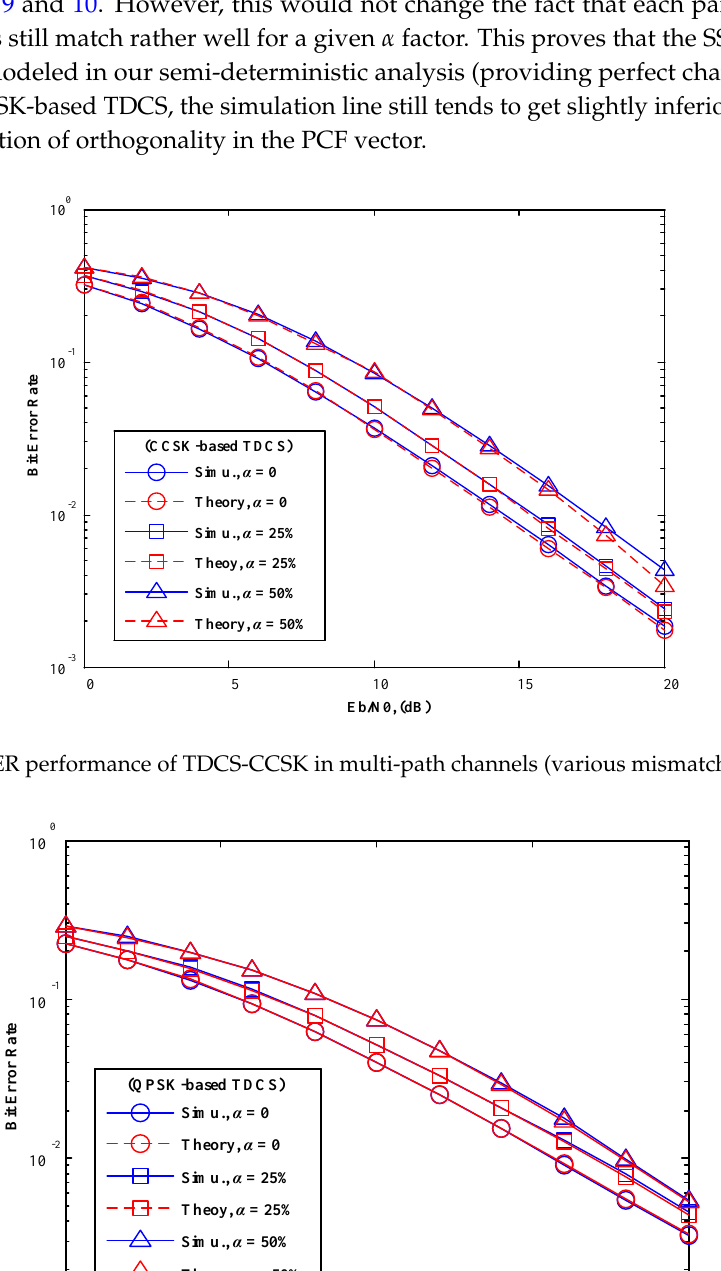
Figure 8. BER performance of TDCS-QPSK in AWGN channels (various mismatch factor α).